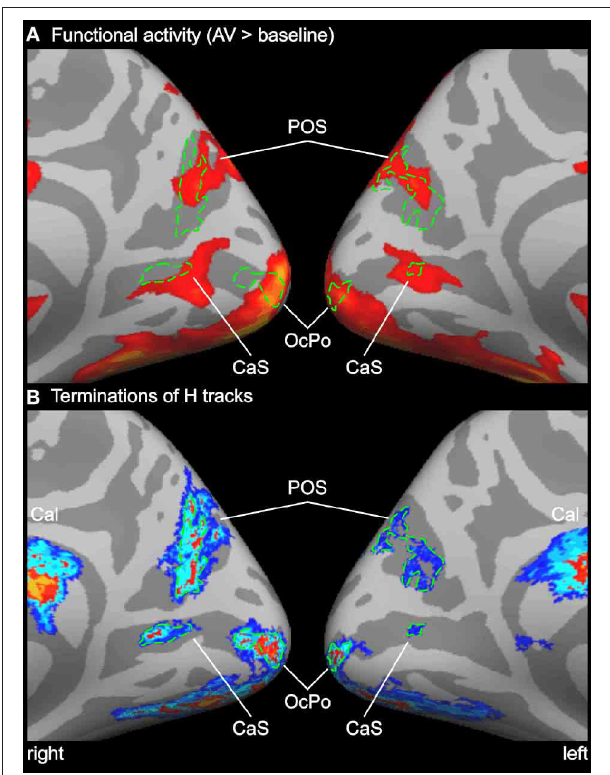
FIGURE 4 | Enlarged view of functional activity and track terminations in medial occipital cortex. (A) Functional activity contrasting BOLD responses to all bimodal stimuli with BOLD responses to control stimuli (A0V0). (B) Termination maps for tracks seeded in the Heschl’s region (H). Labels (ROIs) based on track terminations are shown in green. See also Figures 2 and 3 for